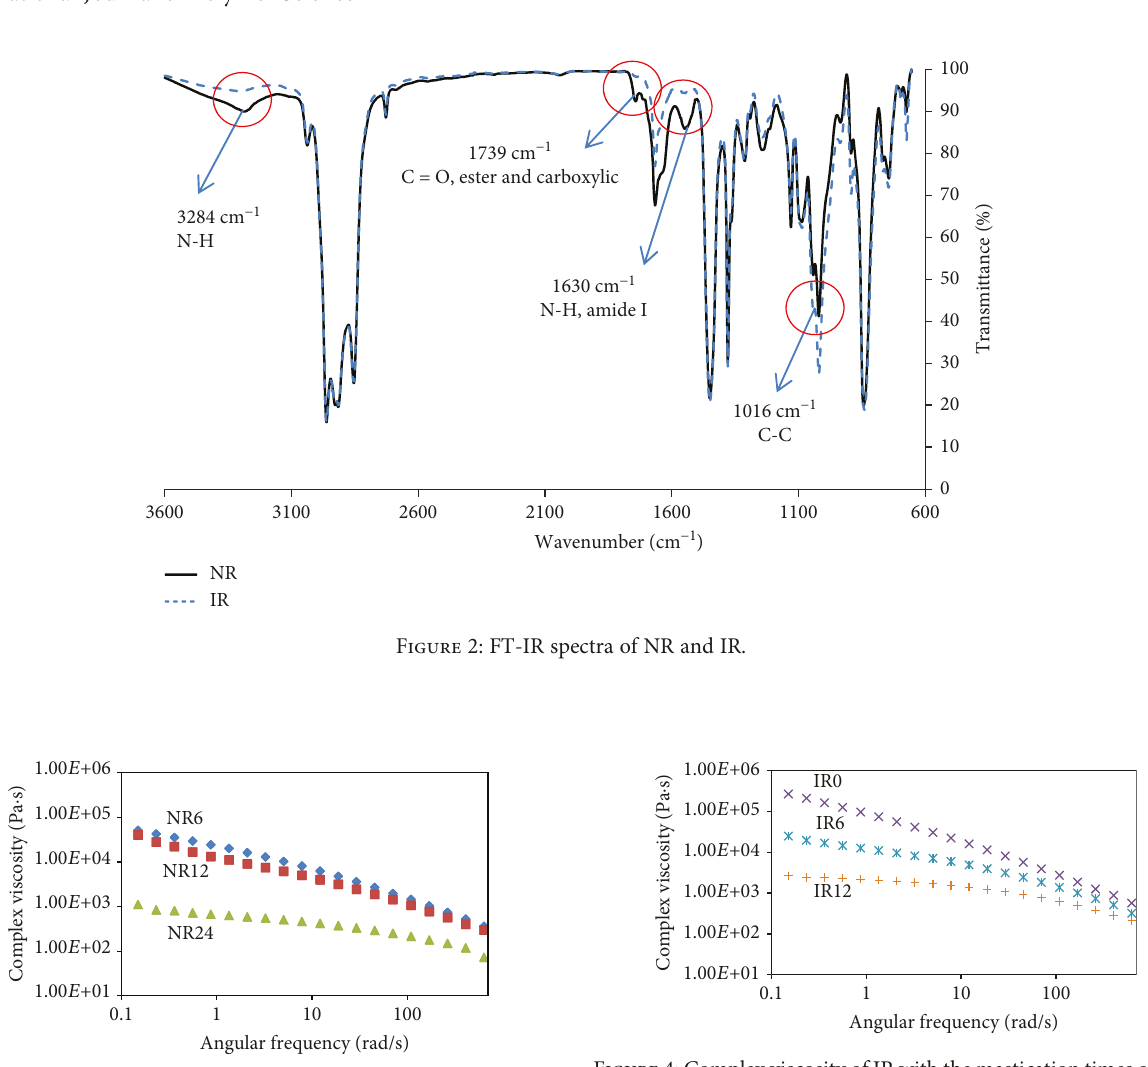
Figure 3: Complex viscosity of NR with the mastication times of 6, 12, and 24 minutes denoted by NR6, NR12, and NR24, respectively.